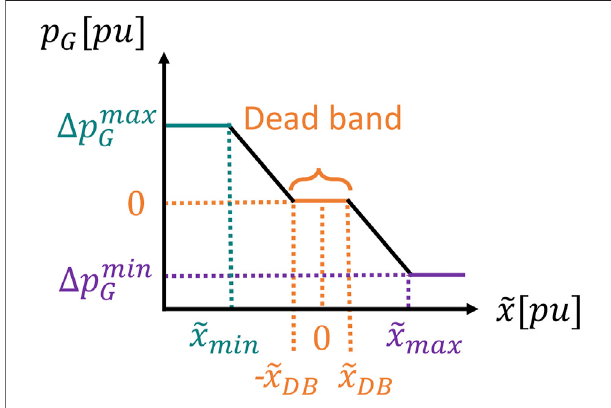
FIGURE 1 | Frequency droop, the main mechanism for primary frequency